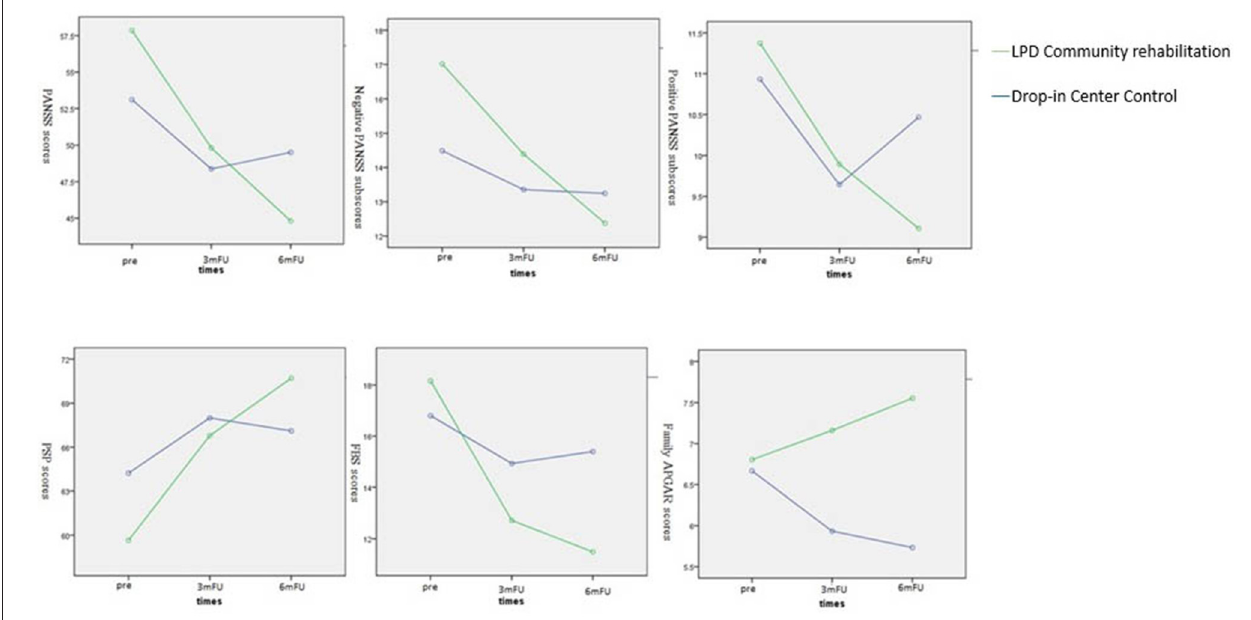
FIGURE 2 | The interaction effects of symptoms, social functioning and family functioning between groups and times. PANSS, Positive and Negative Syndrome Scale; PSP, Personal and Social Performance Scale; FBS, Family Burden Scale of Disease; Family ARGAR, Family ARGAR index; Pre, Pre-intervention; 3mFU, 3-month follow-up; 6mFU, 6-month follow-up; LPD, Lay people